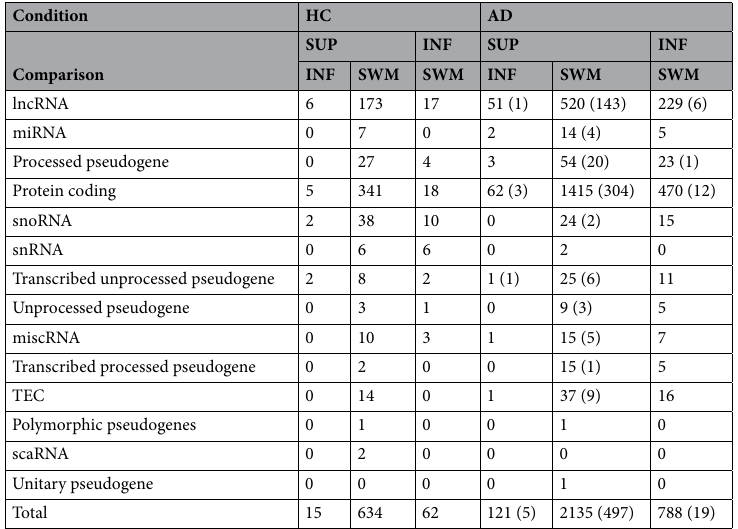
Table 1. DEGs biotype amongst Healthy control and Alzheimer’s disease. The number of DEG in common between the HC and AD comparisons are within